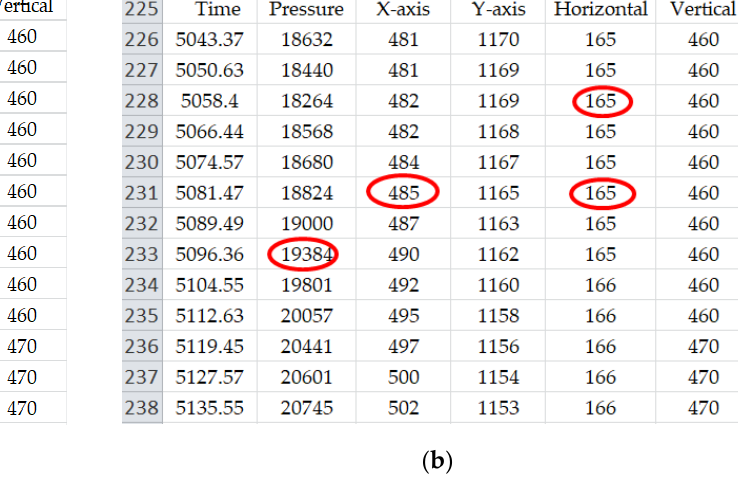
Figure 5. ( a ) Before Imputation ; ( b ) After Imputation.